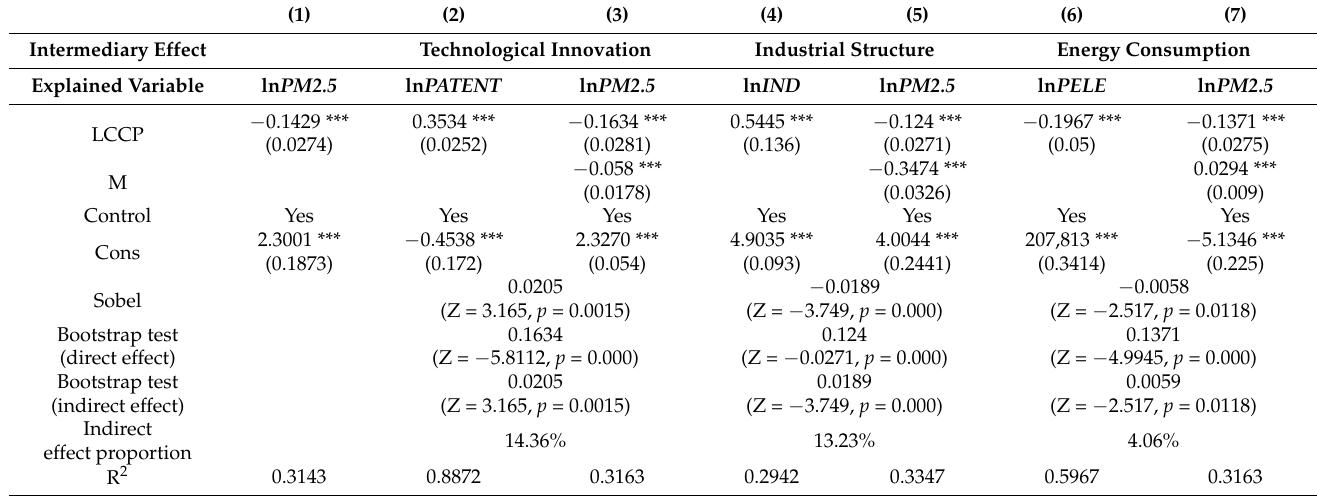
Table 5. Transmission mechanism